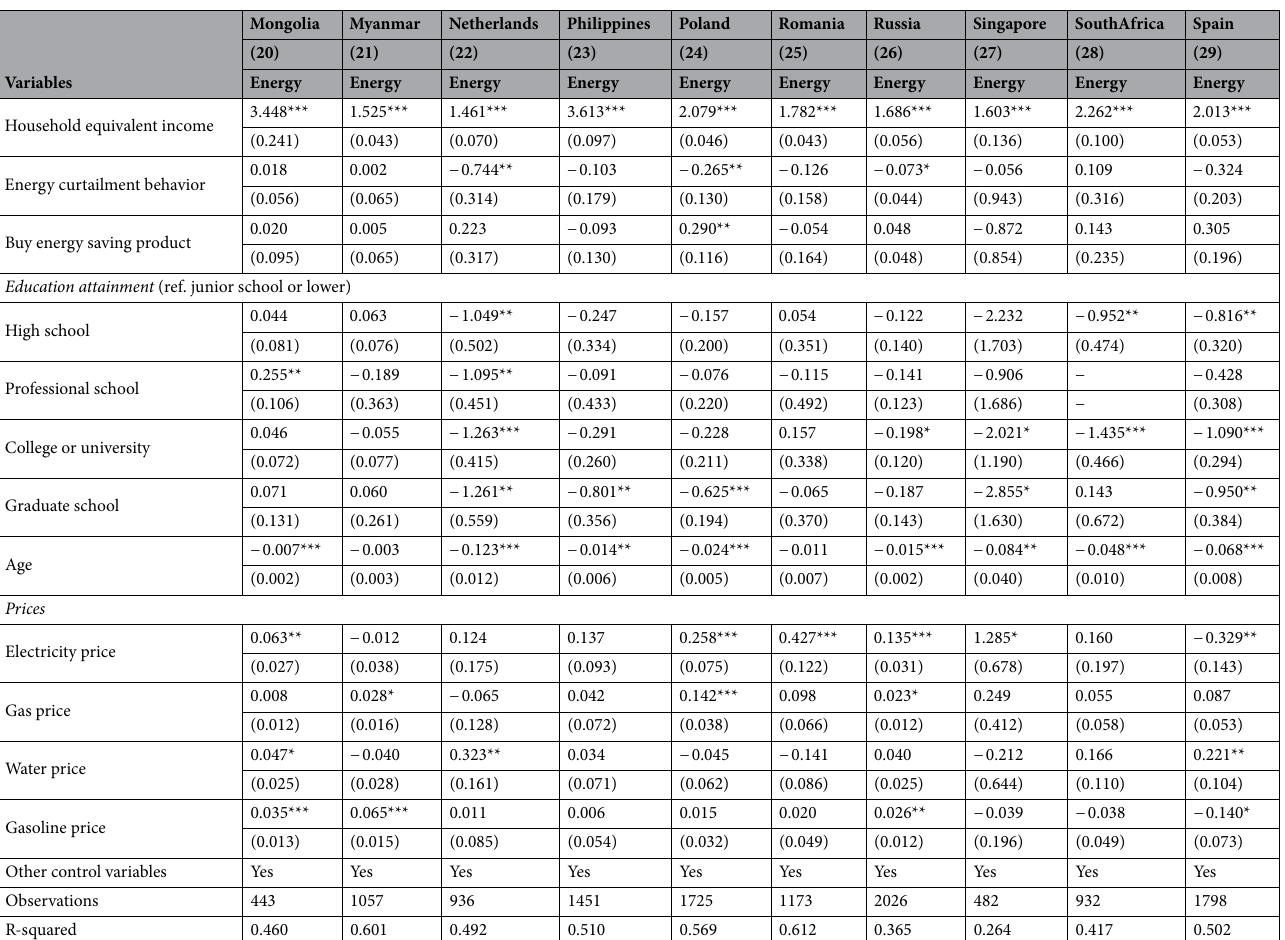
Table 6. Household socioeconomic and demographic determinants of household energy consumption expenditure III. Standard errors in parentheses. *** p < 0.01, ** p < 0.05, * p < 0.1. Other control variables include occupational status, household status, number of children, and gender